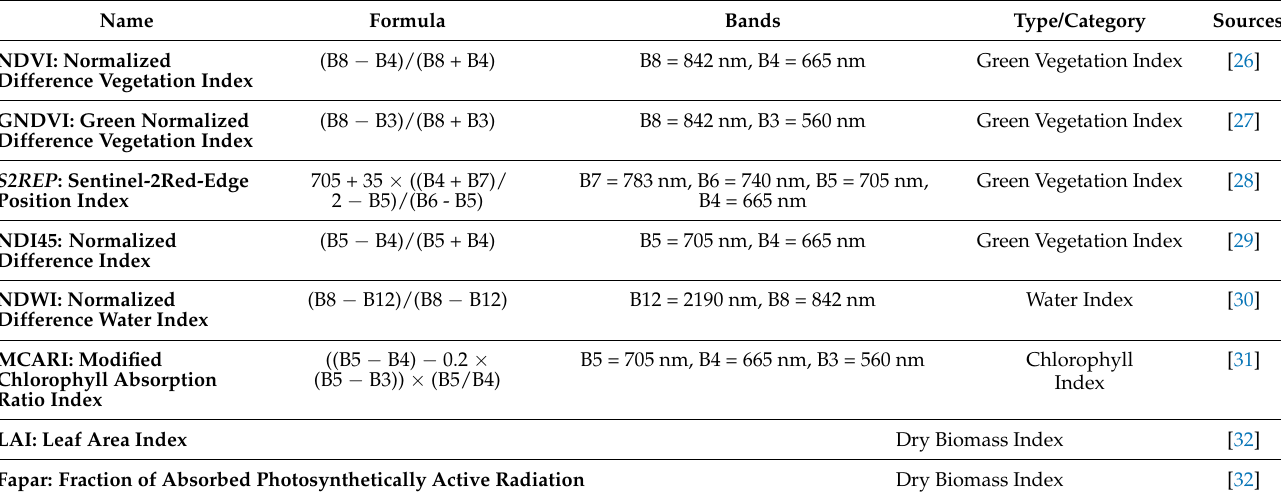
Table 1. Vegetation indices with their major categories derived from Sentinel-2